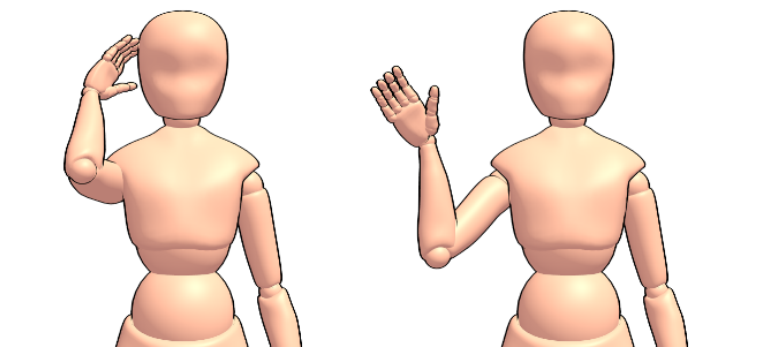
Figure 7. The sign for “Hello” in American Sign